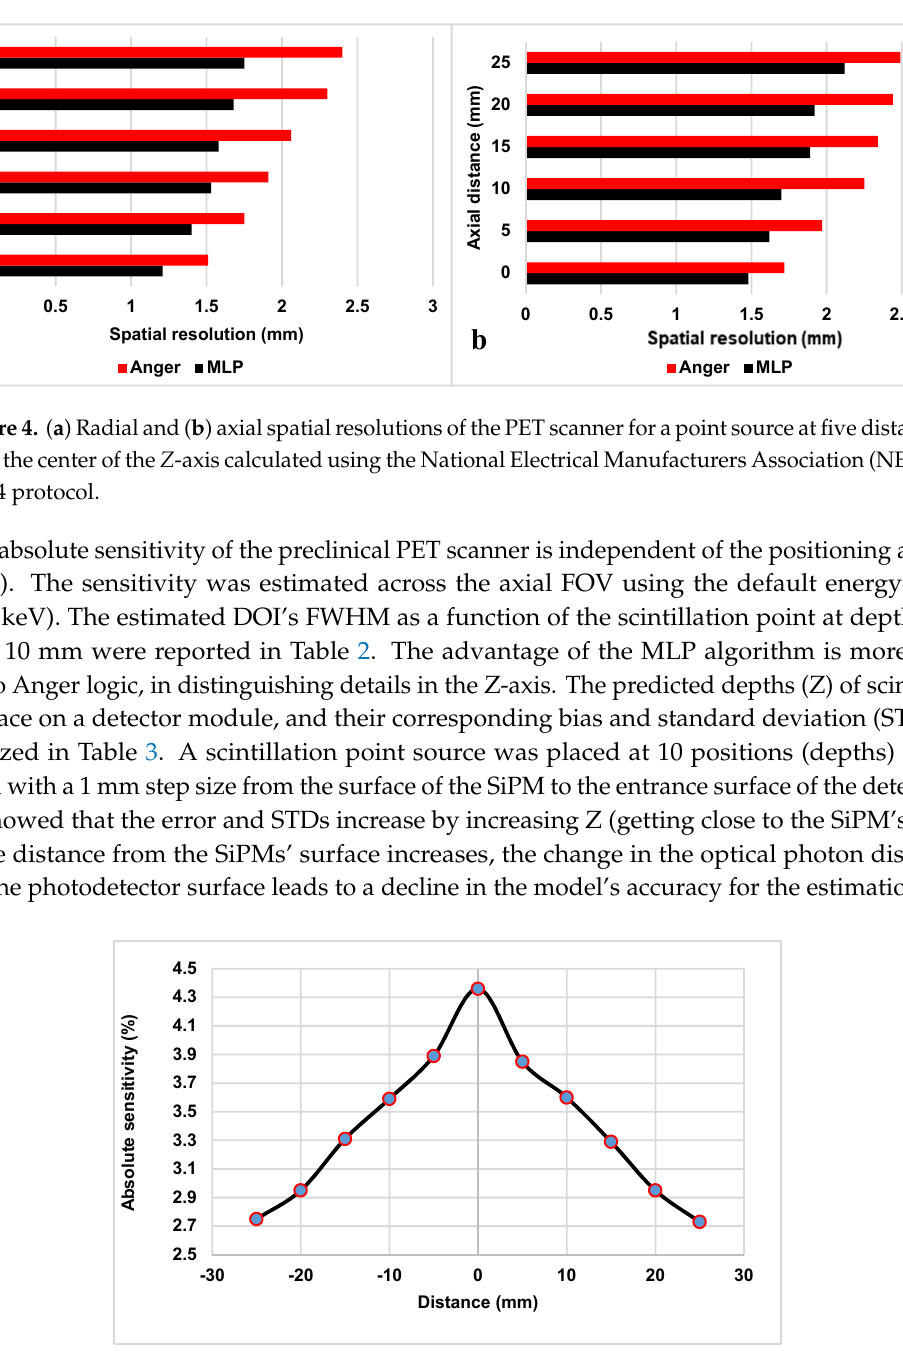
Figure 5. Absolute sensitivity measured at different distances from the center of the field-of-view (FOV) along the Z -axis for the simulated PET scanner.